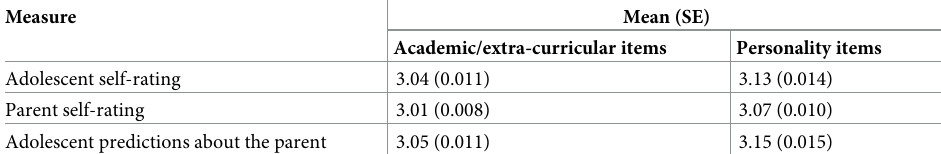
Table 5. Means and standard errors of stereotype endorsement on academic/extracurricular-related items and personality-related items of the trait subscale of the OAT-AM.